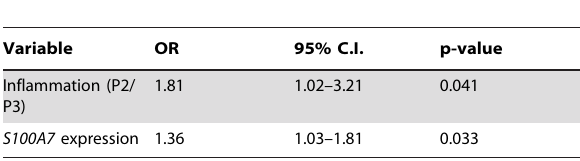
Table 6. Unconditional logistic regression model for baseline factors that associated with recurrent